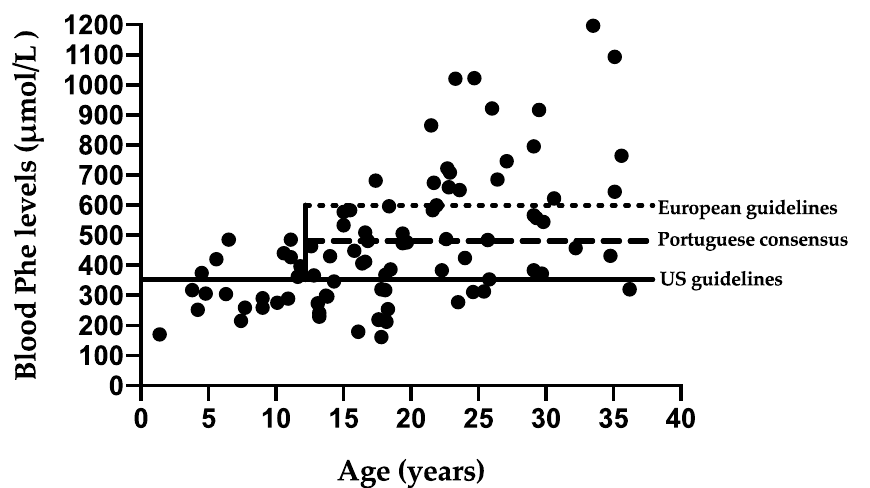
Figure 4. Median annual blood Phe levels presented for each patient compared to three different recommendations.